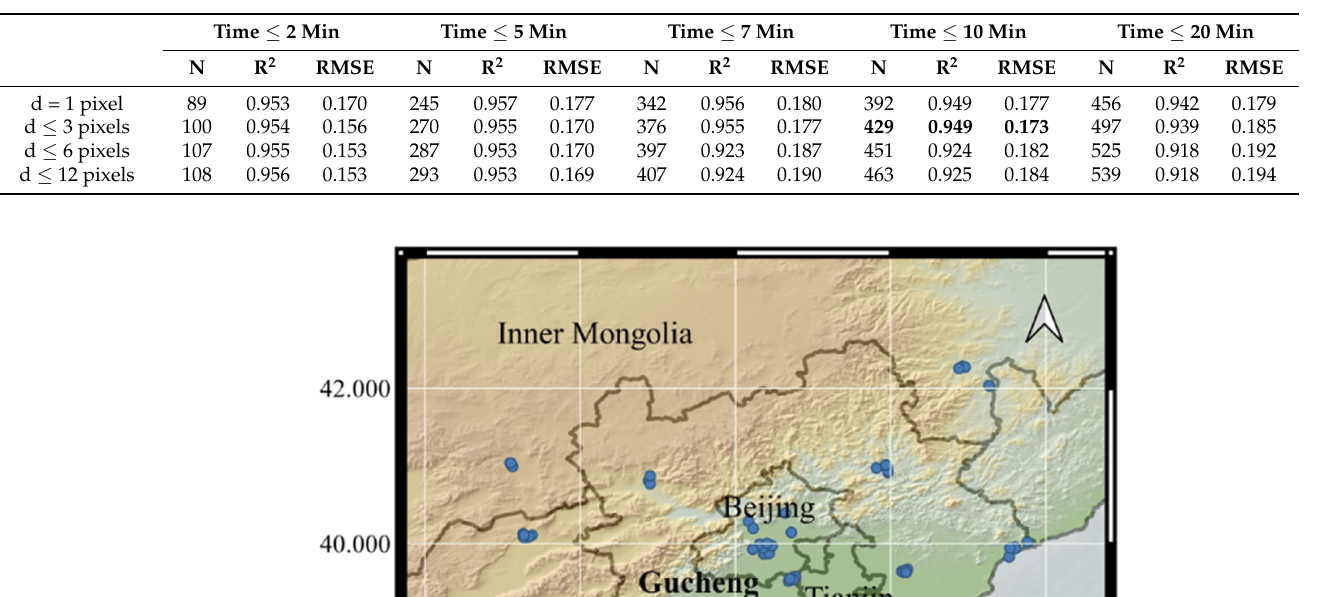
Table 2. Sun photometer ground validation results for MODIS (Moderate Resolution Imaging Spectroradiometer) AOD with different combinations of temporal and spatial screening, The bolded font in the table is the spatio-temporal window we selected.